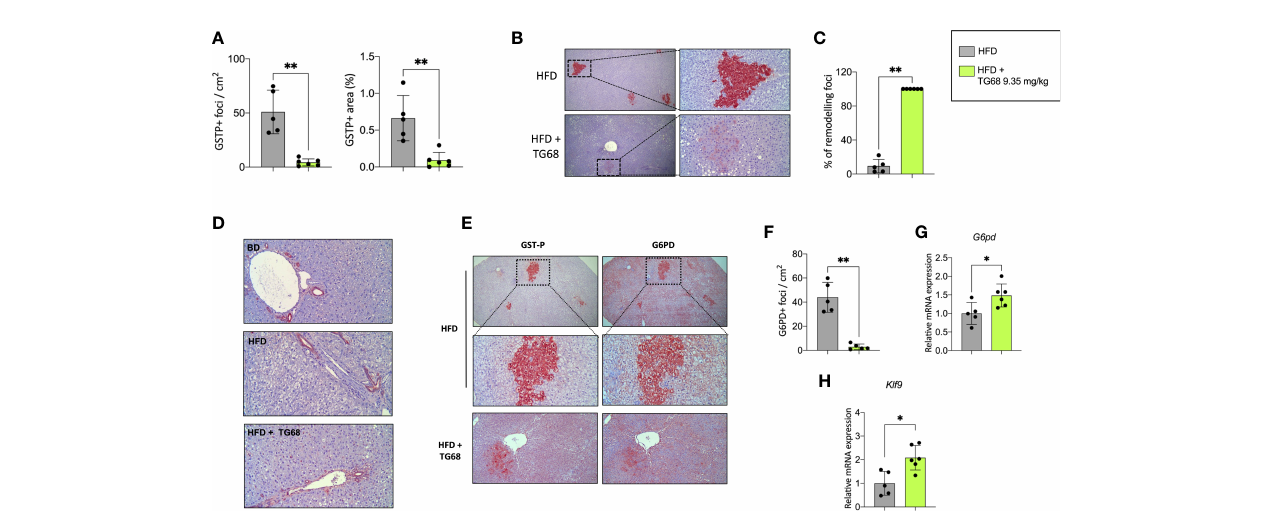
FIGURE 3 Effect of a three-week treatment with TG68 on DEN-induced preneoplastic foci. (A) Number of GSTP+-foci (left panel) and percentage of liver section occupied by GSTP+ lesions (right panel); (B) GSTP immunohistochemical staining of preneoplastic foci of rats fed HFD alone or co-treated with 9.35 mg/kg of TG68 (GSTP, 5X; Inset, 20X); (C) Percentage of remodeling foci in HFD and HFD+TG68 livers; (D) Representative pictures showing GSTP staining in hepatic bile ducts of rats fed Basal Diet (BD), HFD alone or co-treated with 9.35 mg/kg of TG68 (GSTP, 10x); (E) Immunohistochemistry on serial liver sections stained for GSTP and G6PD (GSTP/G6PD: 5x, 20x 10x); (F) Number of G6PD+-foci in rats fed HFD alone or co-treated with 9.35 mg/ kg of TG68; (G) qPCR analysis of G6pd mRNA in rats fed HFD alone or co-treated with TG68; (H) qRT-PCR analysis of Klf9 mRNA levels in rats fed HFD alone or co-treated with TG68. Gene expression is reported as fold-change relative to livers from HFD-fed rats. The bar graphs represent mean values + SD of 5 to 6 rats/group. Groups were compared by using student ’ s t-test. * p <0.05, ** p <0.01. HFD, high fat